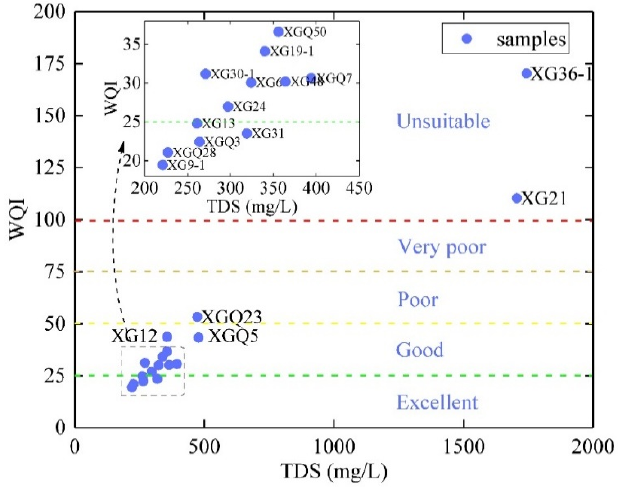
Figure 7. Diagram of groundwater TDS versus WQI .